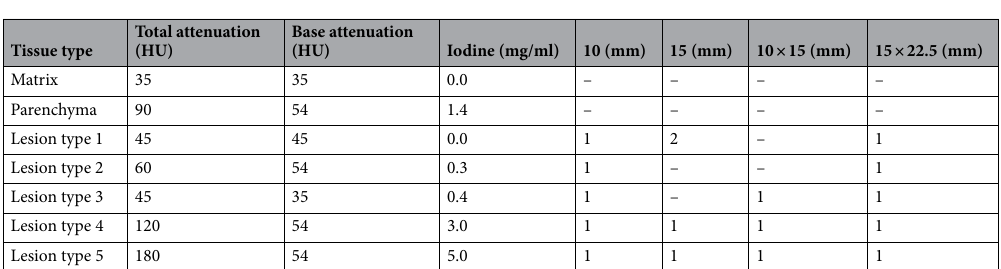
Table 1. Specification of tissue types with liver lesions and size > 5 mm. Of note, iodine concentrations as provided by the vendor are estimates only (as per phantom